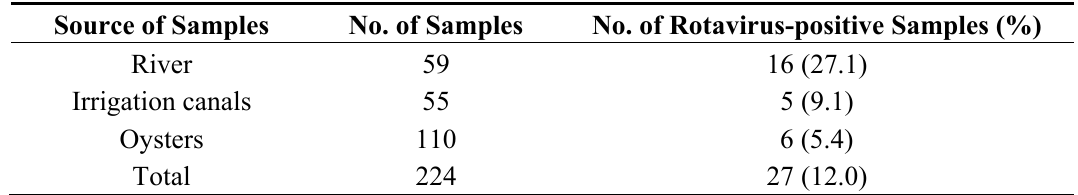
Table 1. Group A rotavirus in environmental water and oyster samples detected by RT-nested